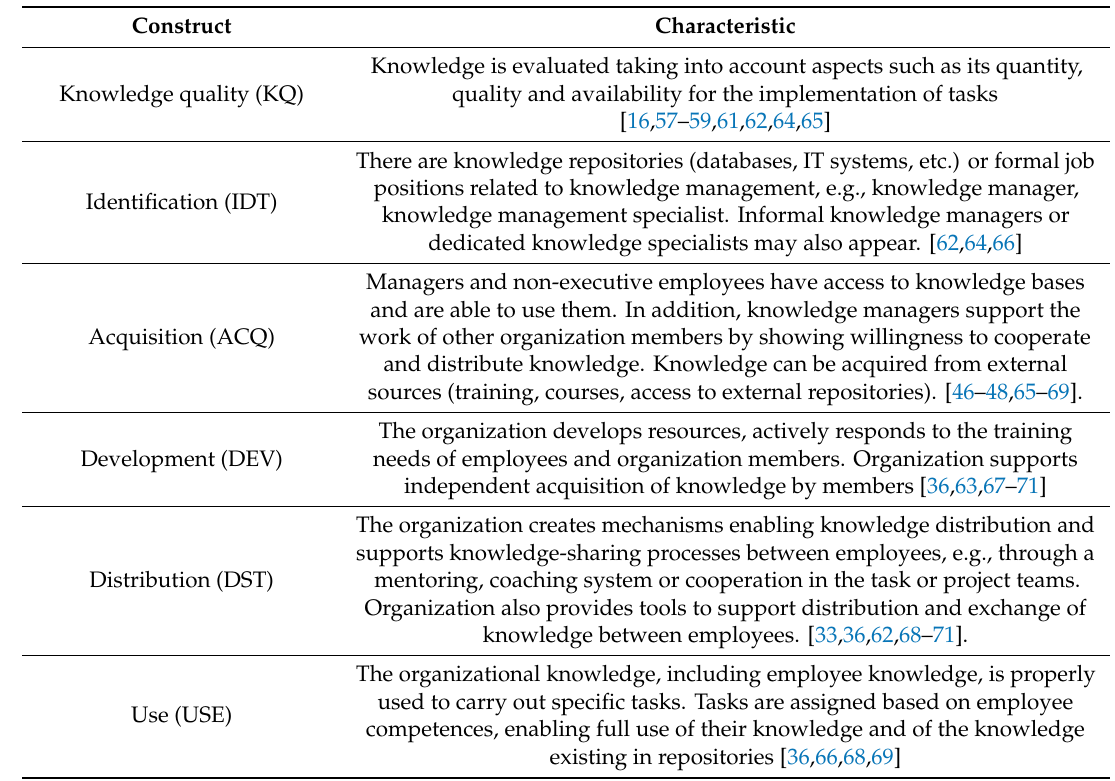
Table 1. Elements influencing evaluations of knowledge quality in knowledge management processes in contemporary